Question: What style of plot is this figure drawn as?
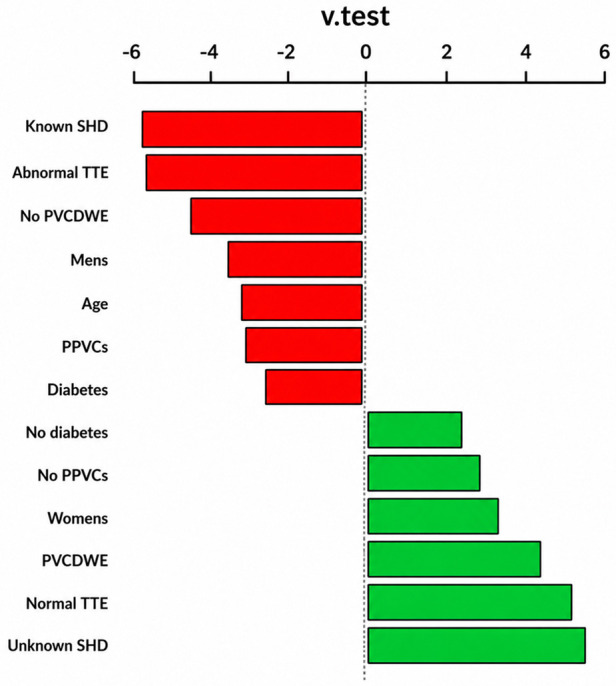
Answer: bar